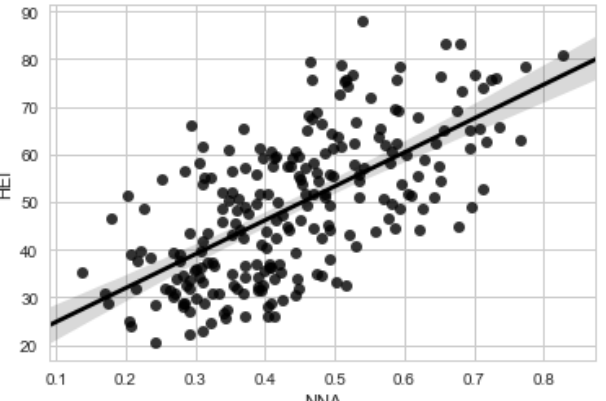
Figure 3. Scatterplot, NHANES 2011–2012, females 31–50 years, energy intake between 1700 and 2300 kcals, day 1 ( n = 155). This shows the relationship between the NNA score (x axis) and the HEI score (y axis) for a subset of NHANES data. NHANES: National Health and Nutrition Examination Survey, NNA: Nestlé Nutrition Algorithm, HEI: Healthy Eating Index.